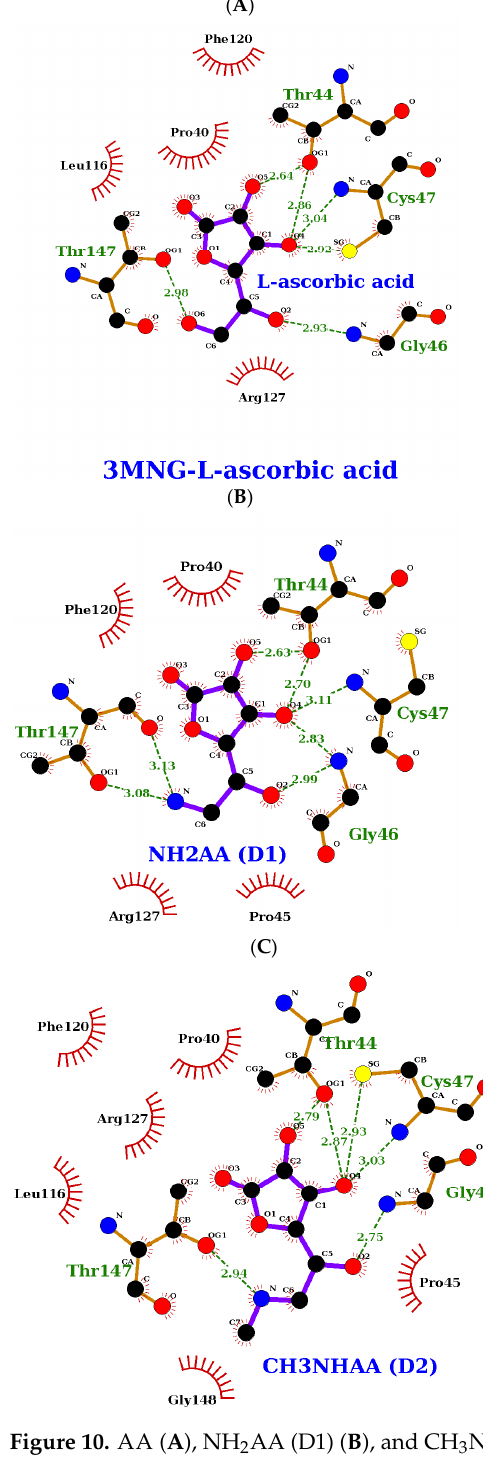
Figure 10. AA ( A ), NH 2 AA (D1) ( B ), and CH 3 NHAA (D2) ( C ) docked to 3MNG.